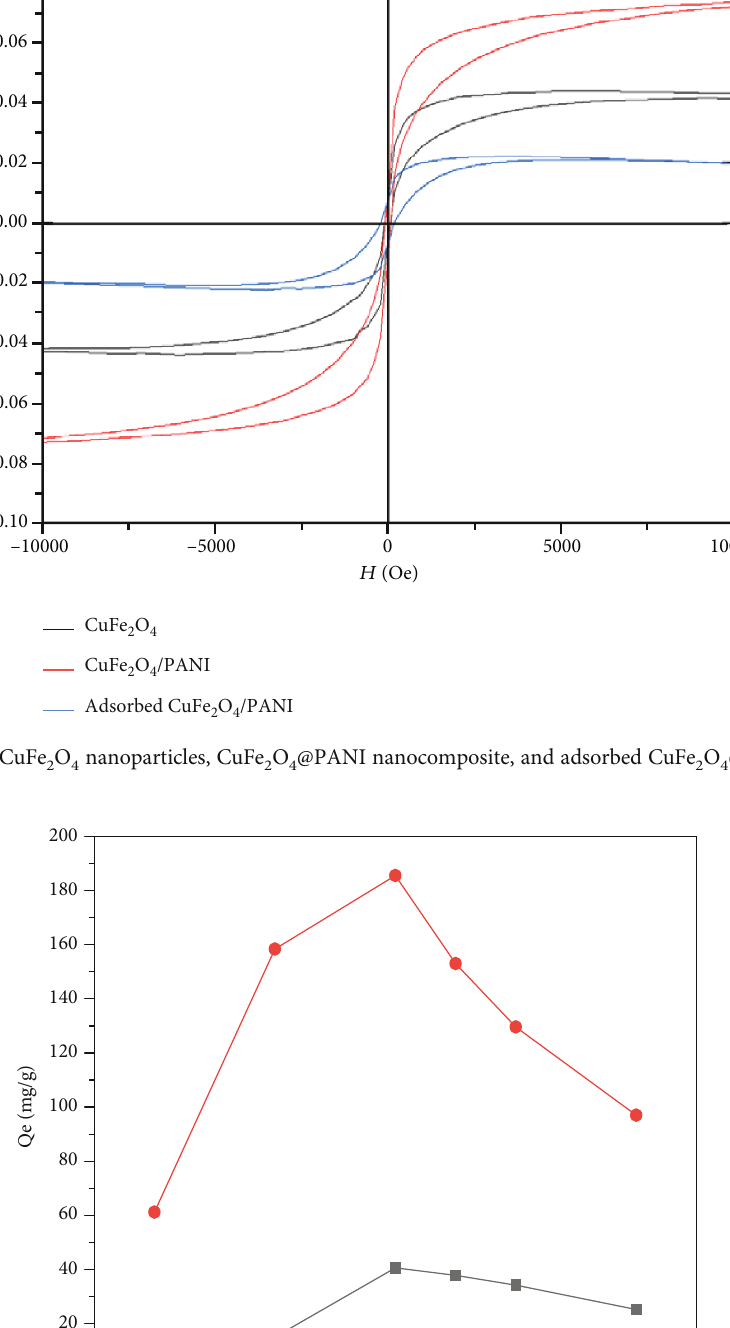
2+ by CuFe O nanoparticles and CuFe 2 2 4